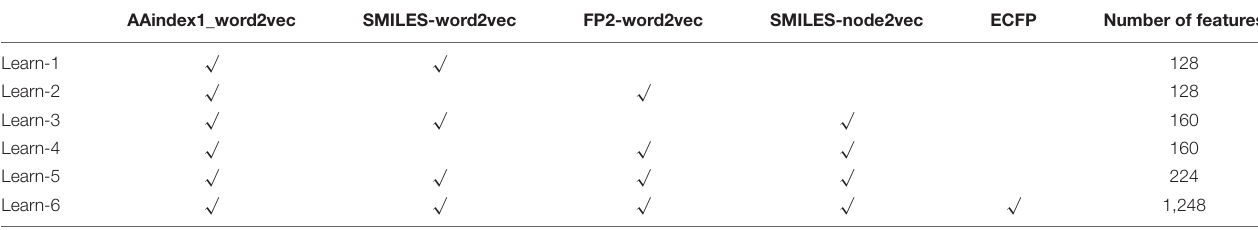
TABLE 2 | Profile of the six learners. AAindex1_word2vec SMILES-word2vec FP2-word2vec